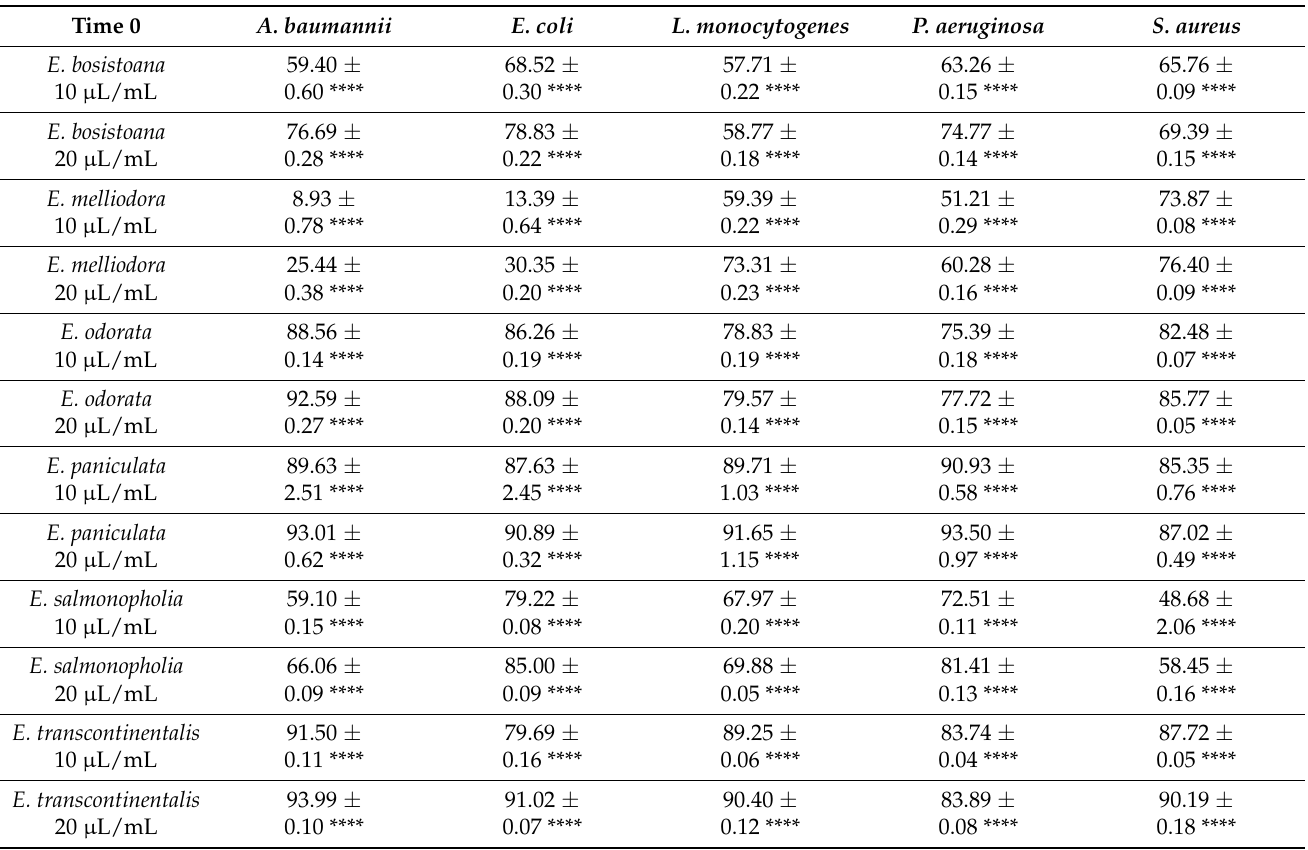
Table 4. Percent inhibition of bacterial biofilm formation caused by the addition of the Eucalyptus EOs at 0 and 24